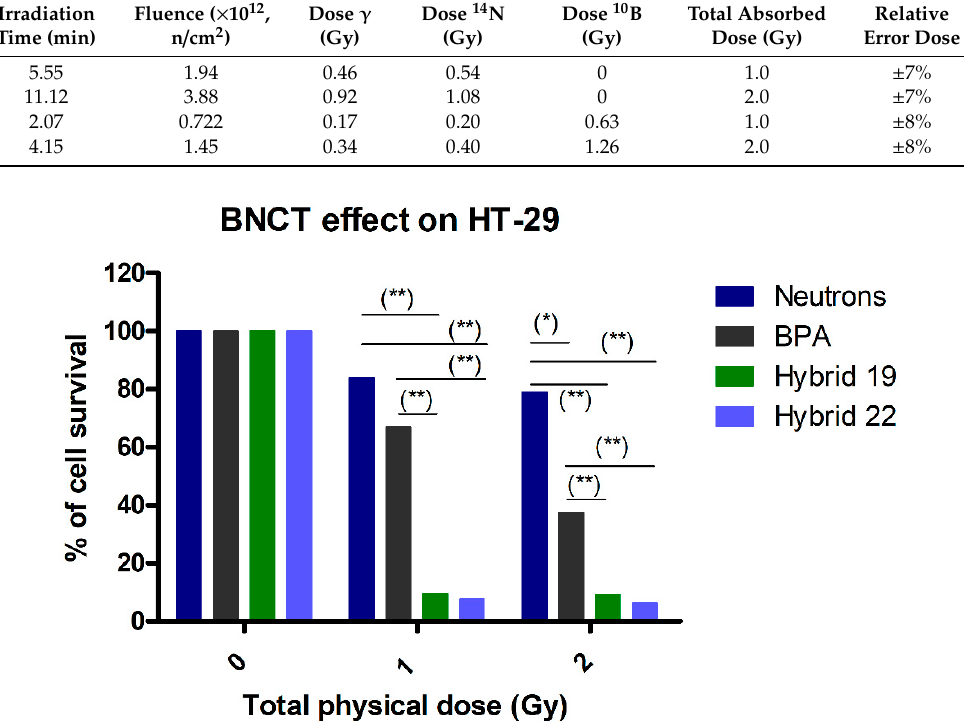
Figure 5. Effect on HT-29-cell survival without or with hybrids 19 and 22 , or BPA treatment post-neutron-irradiation (1 and 2 Gy). Compounds were studied at doses equivalent to 10.0 ppm of 10 B for 1 h of incubation. (*) p < 0.05; (**) p < 0.01.